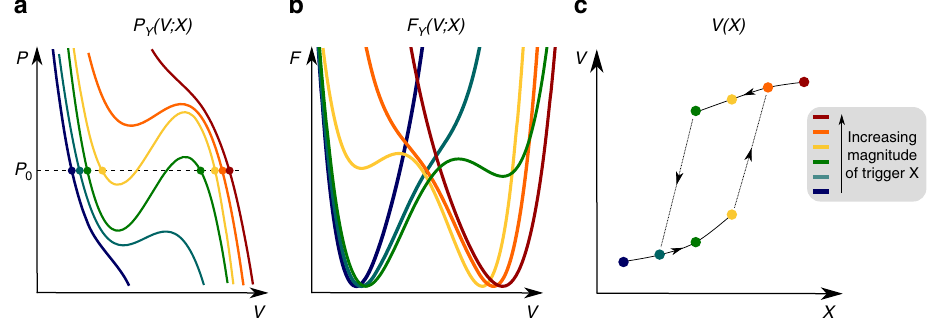
Fig. 5 Illustration of the structural transitions induced by a general state variable X . a Mechanical equation of state b free energy and ( c ) the response V ( X